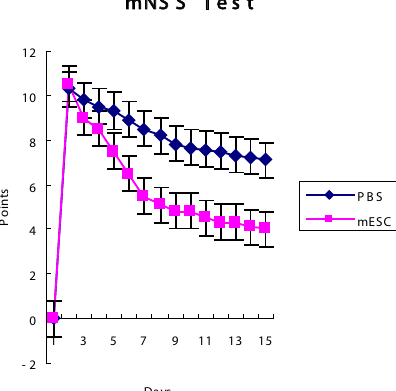
FIGURE 4C - Neurological dysfunctions were examined between control group and mESC-transplanted group. Impaired neurological behaviors were significantly recovered in transplanted group. P<0.05 compared with PBS (n=10) only; P<0.05 compared with cell transplanted group